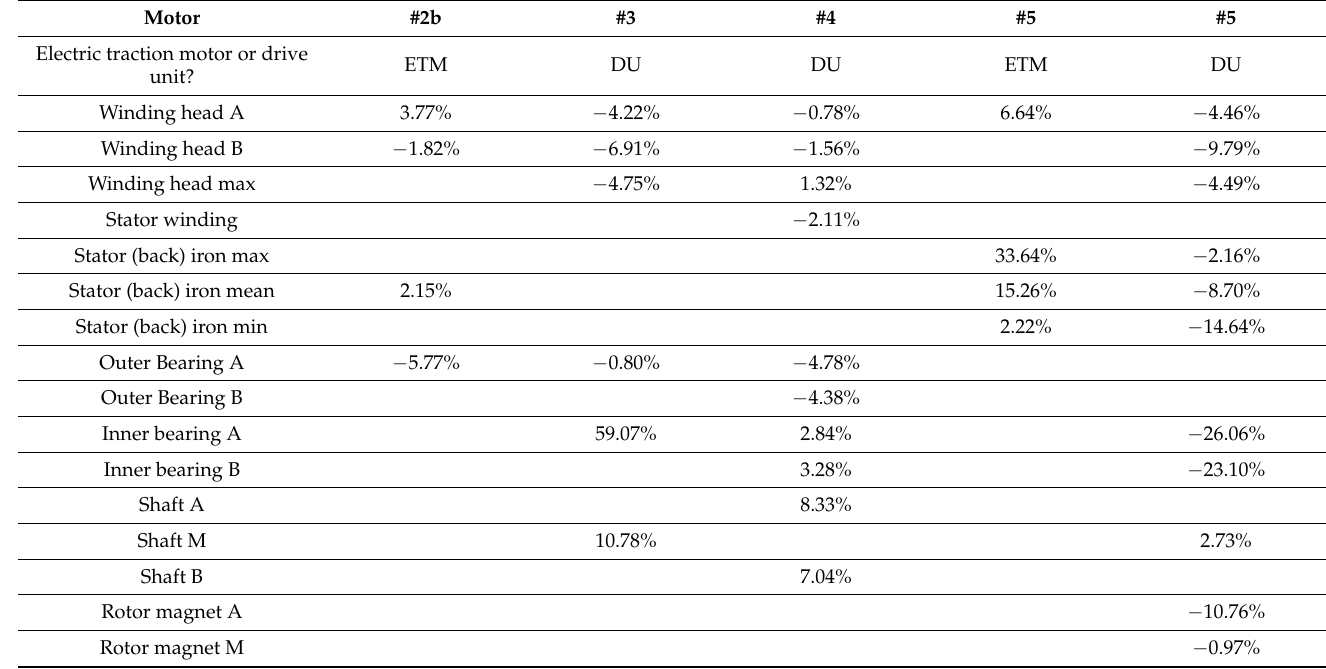
Table 6. Mean relative errors for peak operating points of different electric traction motors and drive